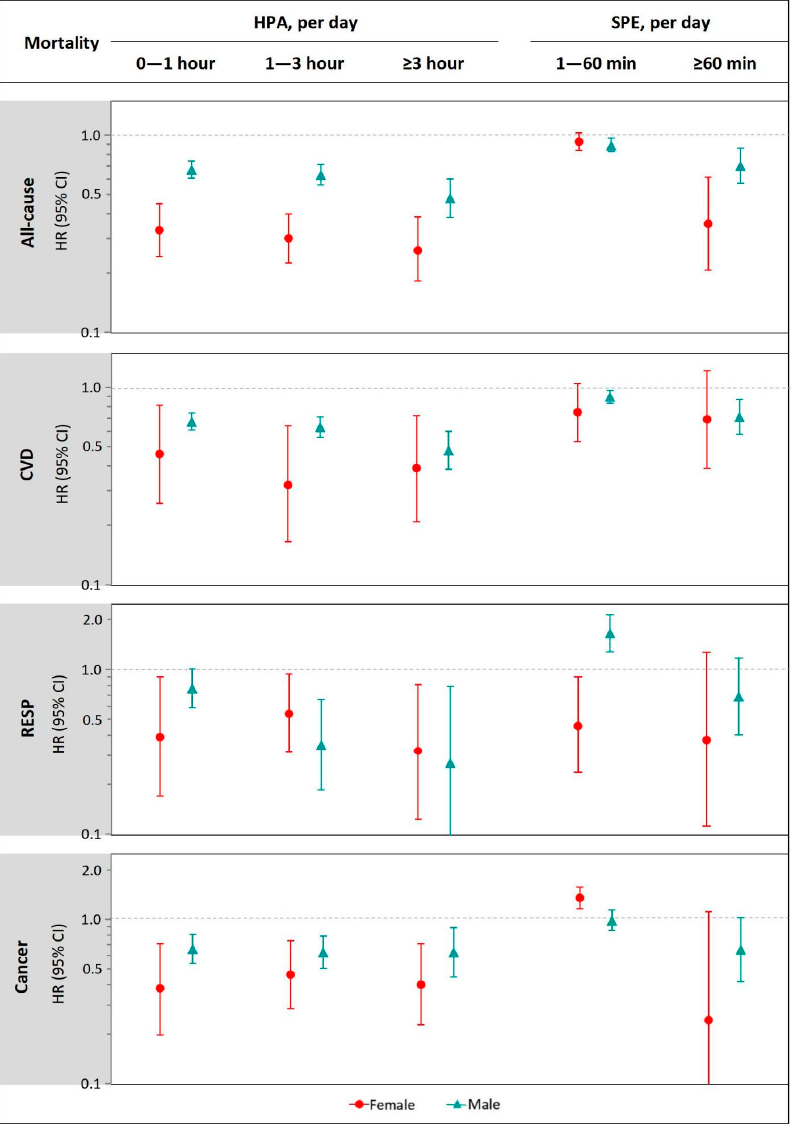
Figure 3. Sex subgroup analysis for association of HPA and SPE with all-cause, CVD, RESP, and cancer mortality. We adjusted for gender, age, BMI, ethnicity, marital status, residential region, geolocation, education attainment, employment status, household income, smoking status, alcohol consumption, sleep duration, and chronic disease. Abbreviations: HPA, household physical activity; SPE, sport and physical exercise; CVD, cardiovascular disease; RESP, respiratory disease; BMI, body mass index; HR, hazard ratio; CI, confidence